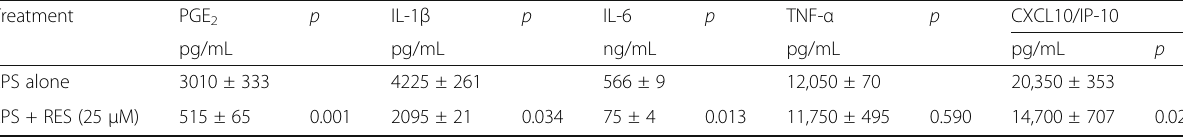
Table 2 Resveratrol reduced the secretion of cytokines and chemokines in LPS-activated THP-1 cells Treatment PGE